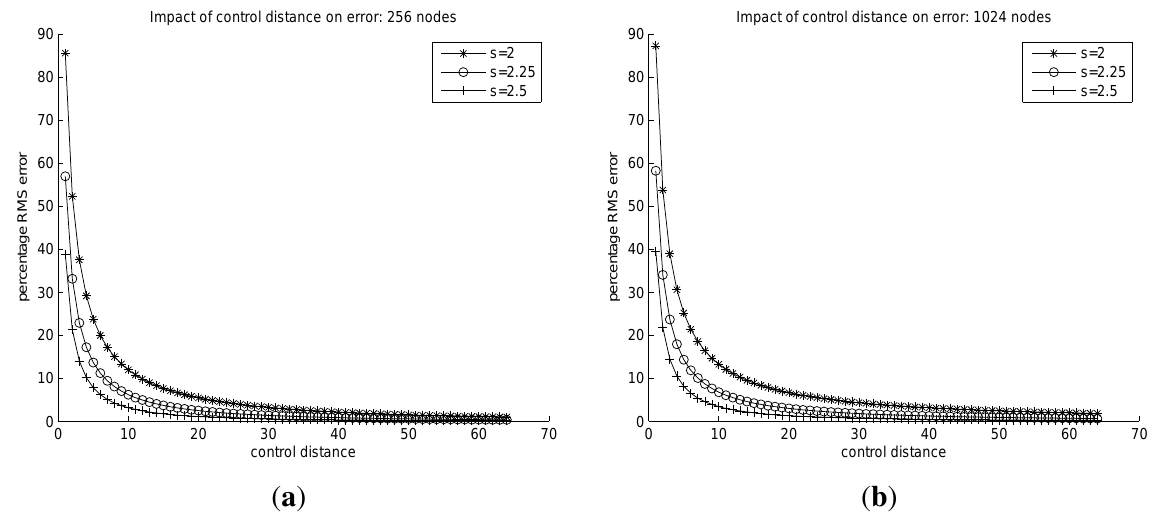
Figure 4. ( a ) Impact of control distance on the root mean square error across all sensors for a 256 node network; ( b ) impact of control distance on the root mean square error across all sensors for a 1 , 024 node network.